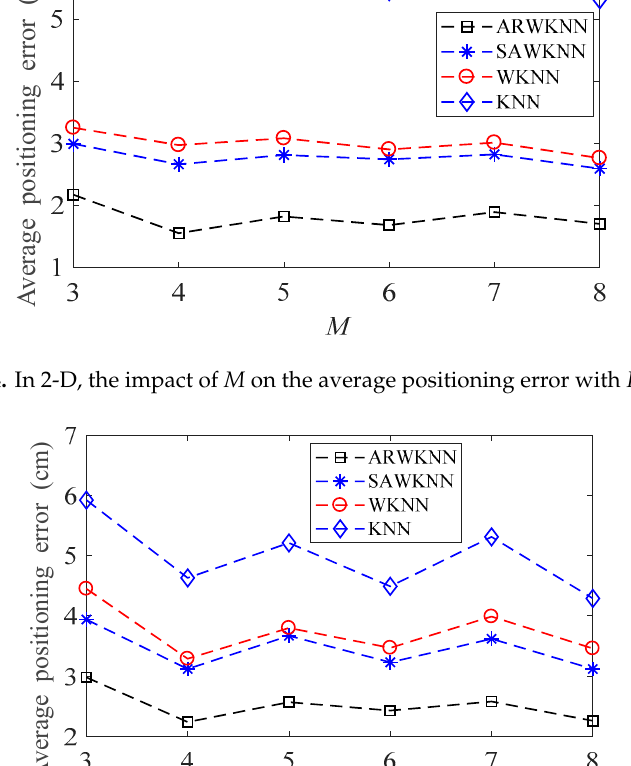
Figure 15. In 3-D, the impact of M on the average positioning error with K max = 8.